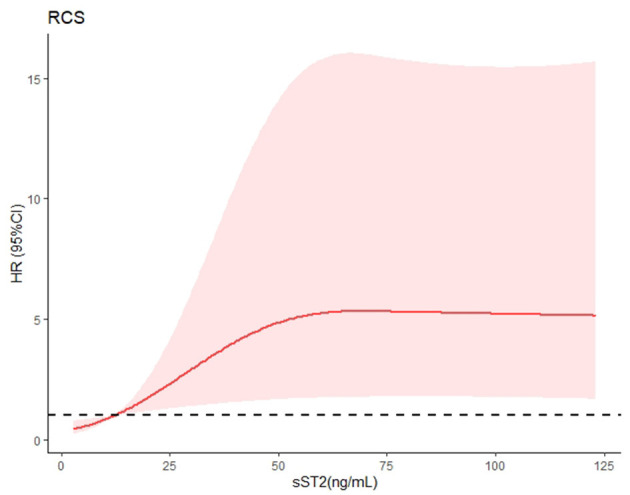
Restrictive cubic spline (RCS) modeling was used to visualize the relationship between sST2 and mortality in AL patients with cardiac involvement. This figure depicts sST2 as a continuous variable in RCS modeling. The risk of mortality increased with increasing sST2 concentrations (P for non-linearity <0.01). A broken black line indicates that the hazard ratio equals 1.